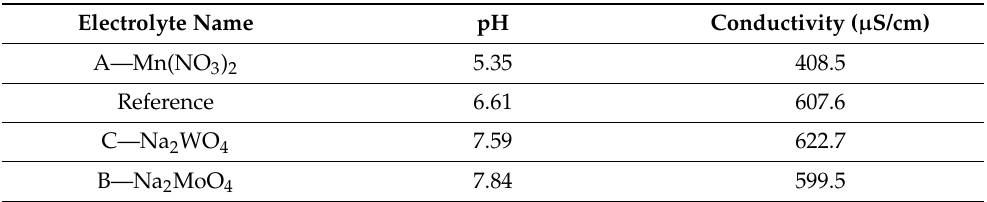
Table 2. pH and conductivity of tested